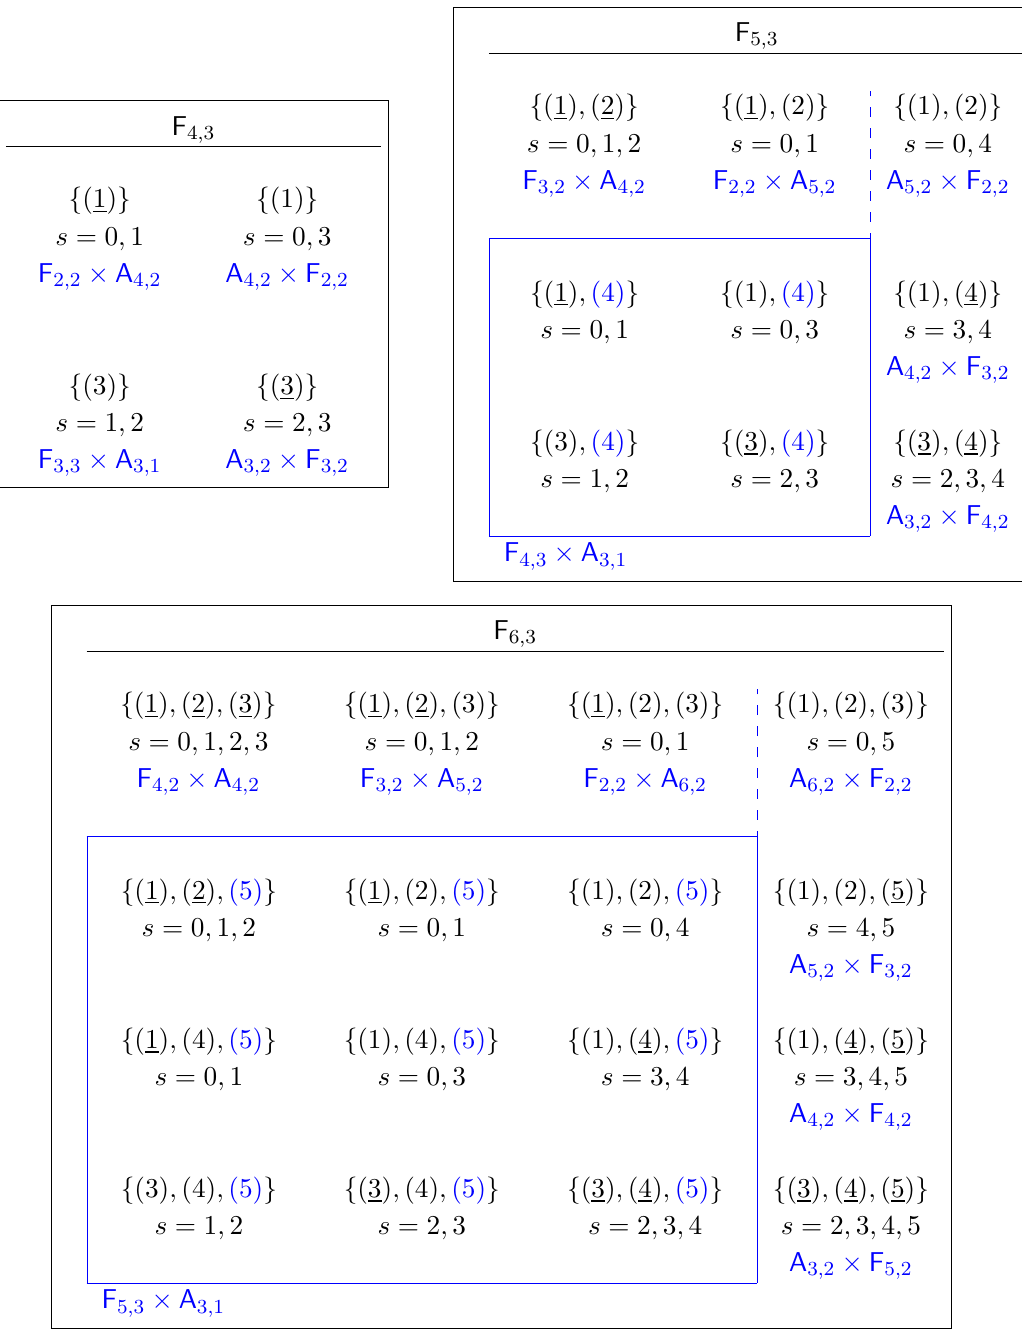
Figure 2 . Poles contributing to the four, (cid:12)ve and six-point NMHV form factors. The corresponding factorization channels are indicated in blue, and we list all possible values of the shift s , which label the Gra(cid:25)mannian top forms featuring the respective pole. The blue boxes contain the poles from the inverse soft limit of the lower-point form factor, which share the vanishing minor ( n (cid:0) 1) appended to the contour of F n (cid:0) 1 ; 3